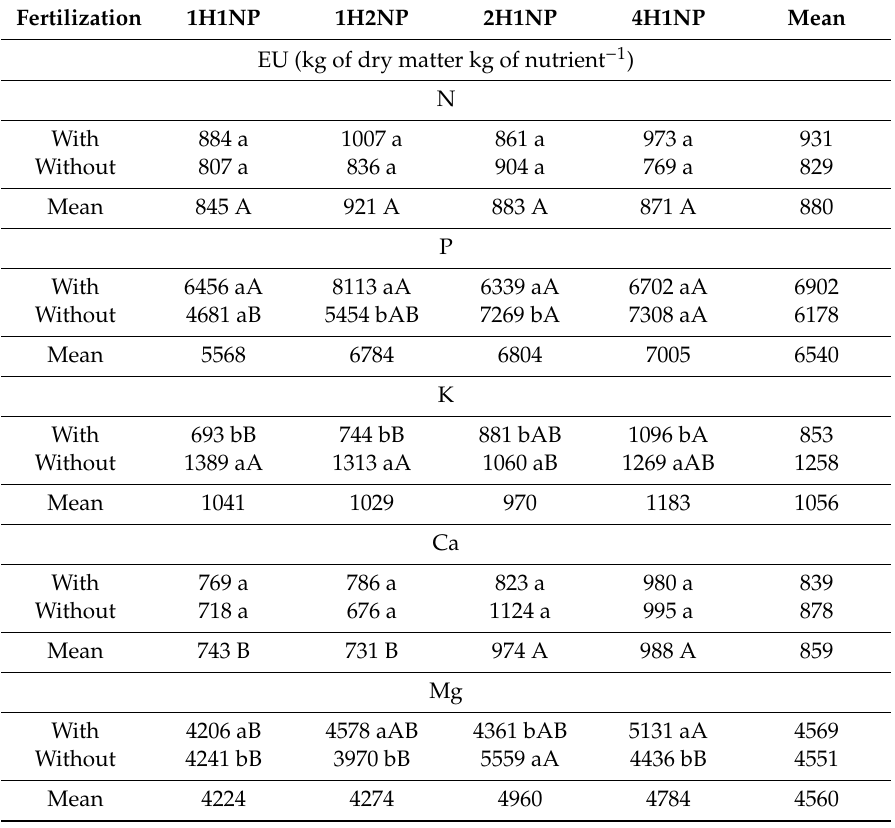
Table 7. E ffi ciency of utilization (EU) of N, P, K, Ca and Mg in the trunk of the clone GG157, at 60 months of age, in response to liming / fertilization (With or Without) and height (H) and number (NP) of poles per stump at the time of pole